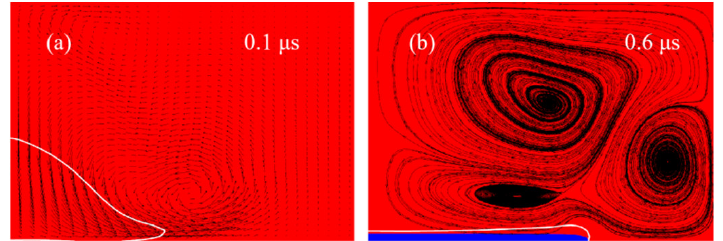
Figure 10. Velocity field at ( a ) 0.1 μs and ( b ) 0.6 μs for the YSZ drop impact.